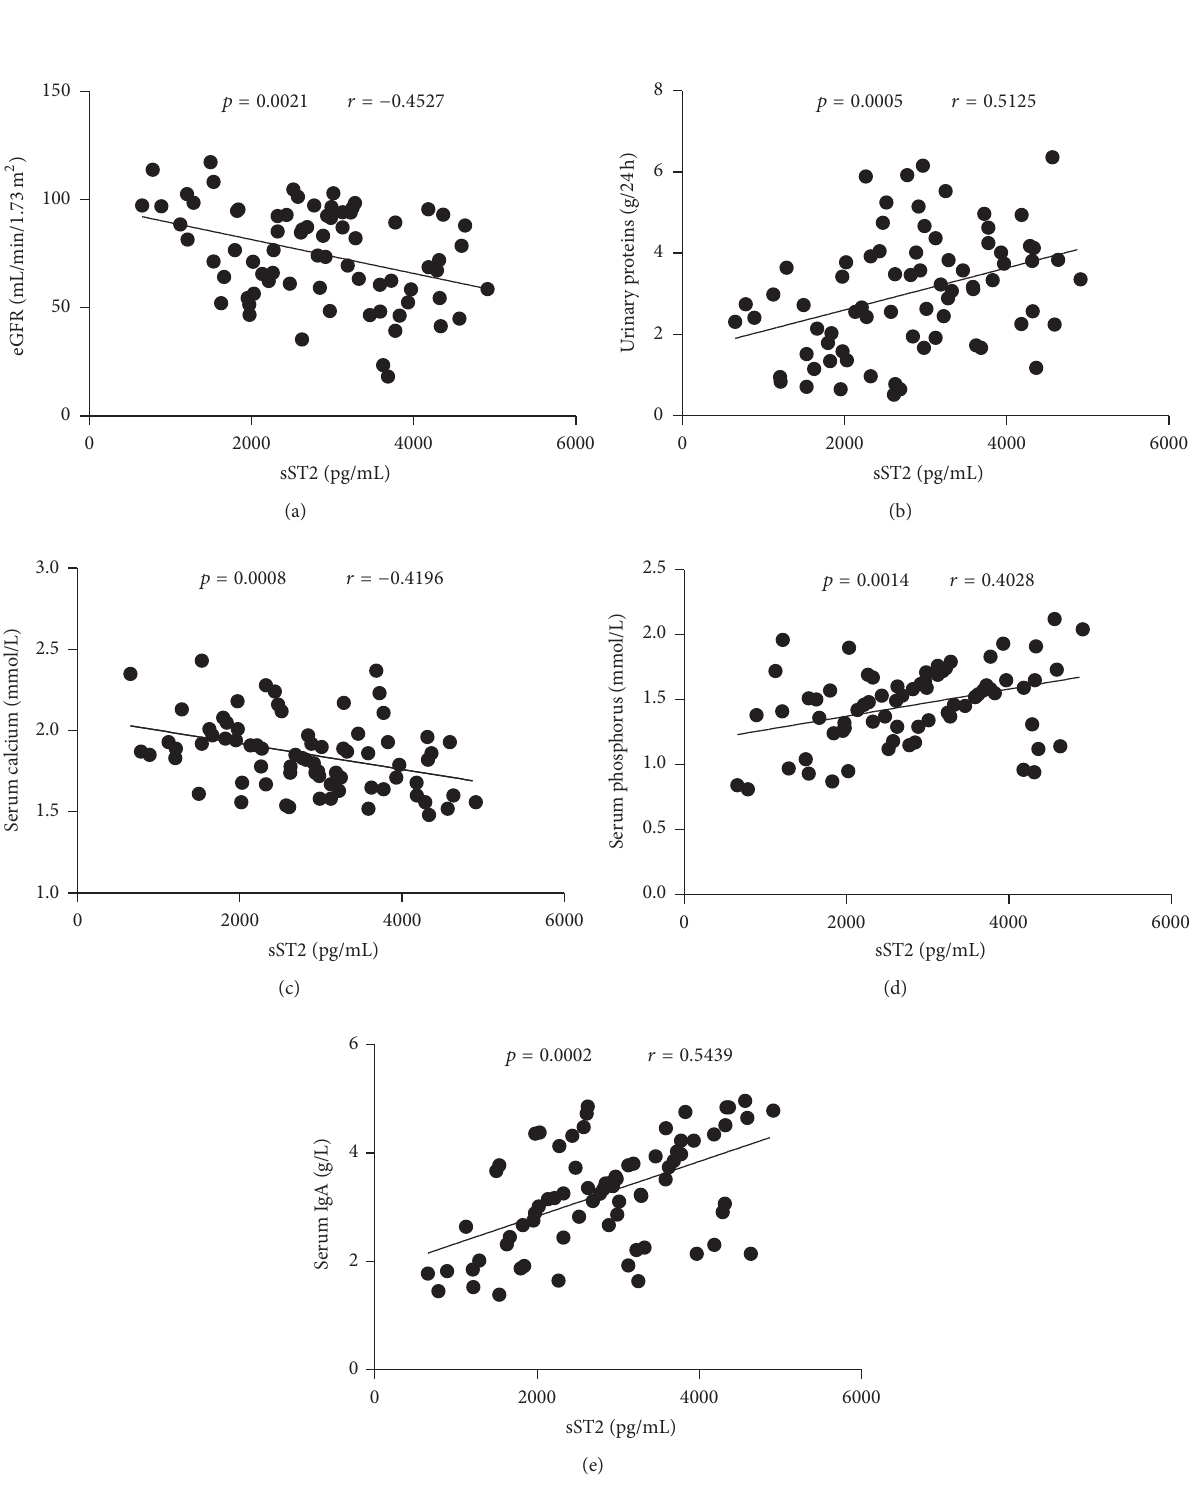
Figure 3: Correlation analysis of serum sST2 with the values of clinical parameters in IgAN patients. The potential correlations between serum sST2 and the values of clinical parameters were analyzed by Spearman correlation tests. Data shown are the mean concentration of individual subjects from two separate experiments. (a) Serum sST2 levels were correlated negatively with the values of eGFR. (b) Serum sST2 levels were correlated positively with the concentrations of 24-hour urinary proteins. (c) Serum sST2 levels were correlated negatively with serum calcium. ((d)-(e)) Serum sST2 levels were correlated positively with serum phosphorus and serum IgA,